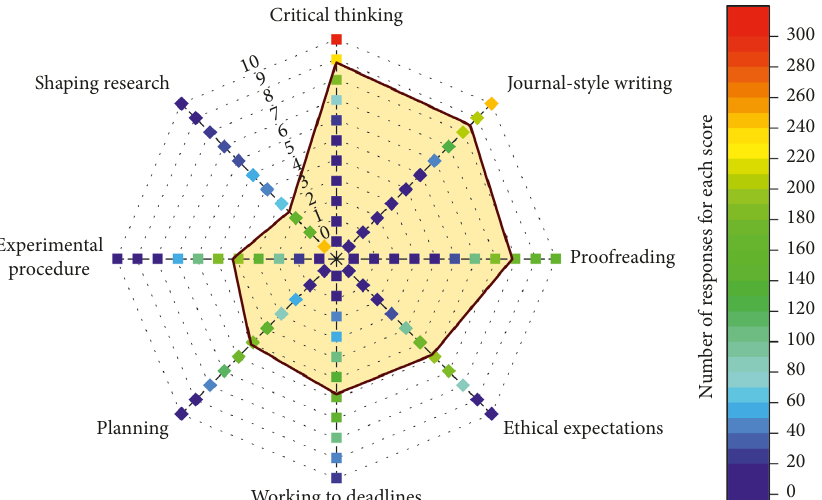
Figure 5: Statistics for the educational value of peer review (0–10) towards 8 skills needed for ECRs (yellow fill: mean scores; scale bar: number of responses for each score